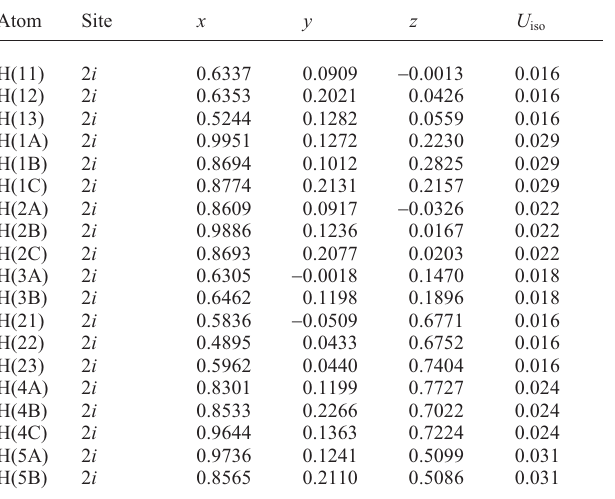
Table 2. Atomic coordinates and displacement parameters (in Å 2 ) .